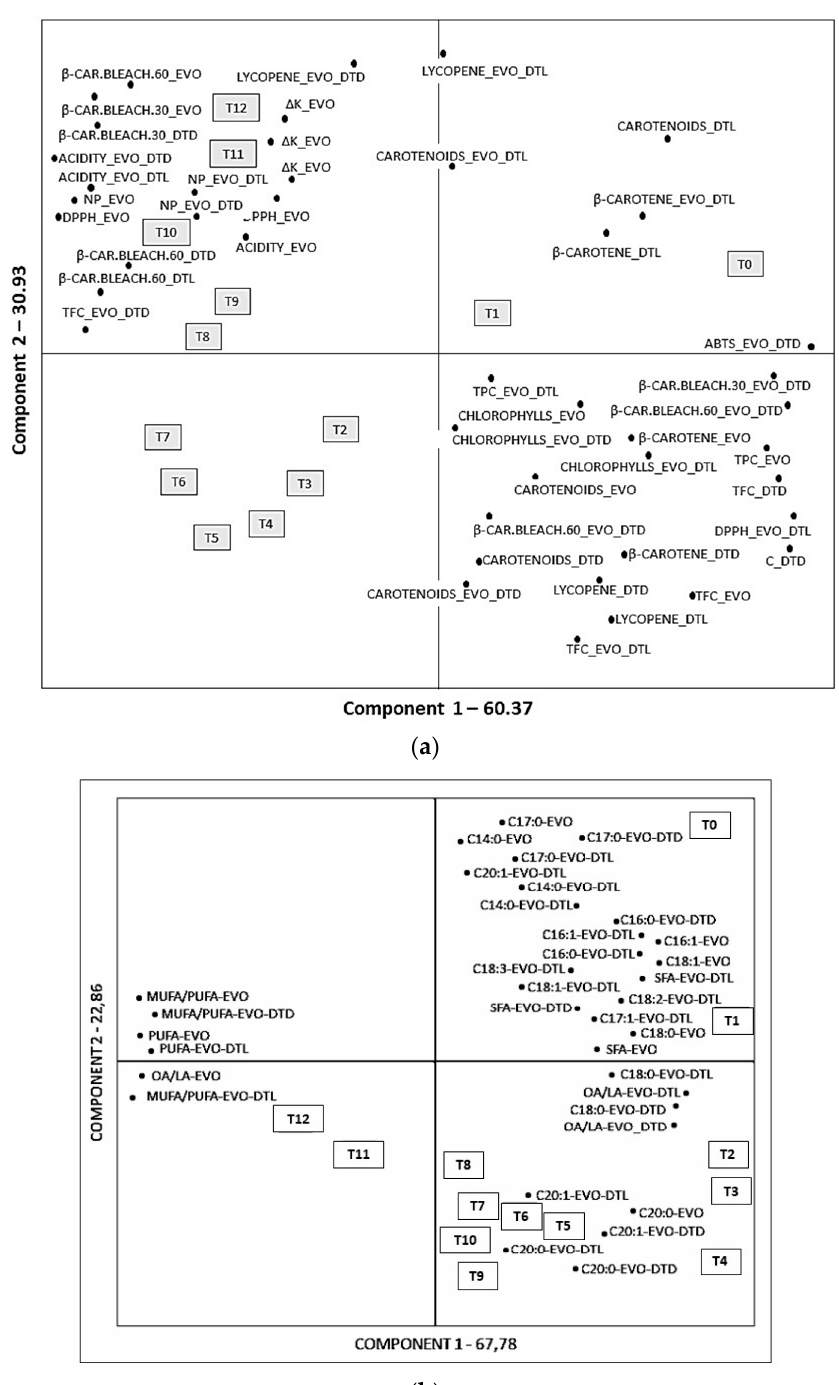
Figure 2. ( a ) Score plot of principal components 1 and 2 for chemical parameters, bioactive molecules, and antioxidant activity of the tomato dried and extra virgin olive oil samples stored in light (DTL) and darkness (DTD). ( b ) Score plot of principal components 1 and 2 for fatty acids of the tomato dried and extra virgin olive oil stored in light (DTL) and darkness (DTD). T0-T12: months of analytical monitoring.